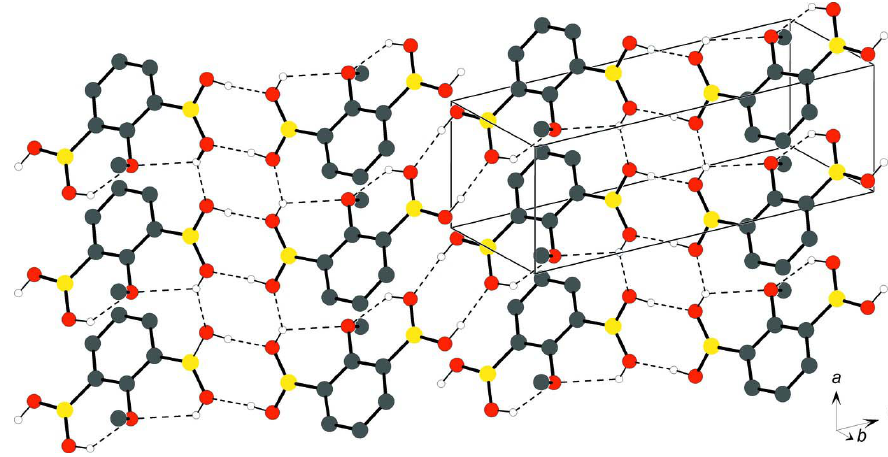
Figure 2 The hydrogen-bonding pattern. Hydrogen bonds are shown as dashed lines. (2-Methoxy-1,3-phenylene)diboronic